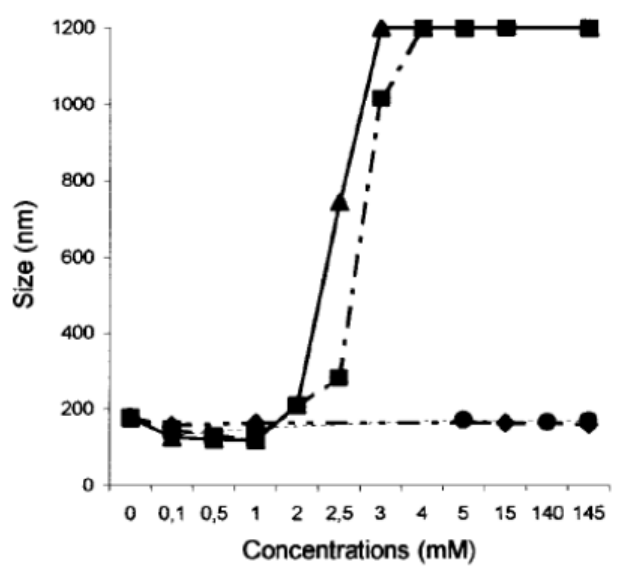
Figure 20. Variation of the diameter of solid lipid nanoparticles formed by 14 in the presence of varying concentrations of Na + ( ♦ ); K + ( ● ); Mg 2+ ( ■ ); and Ca 2+ ( ▲ ) [86].